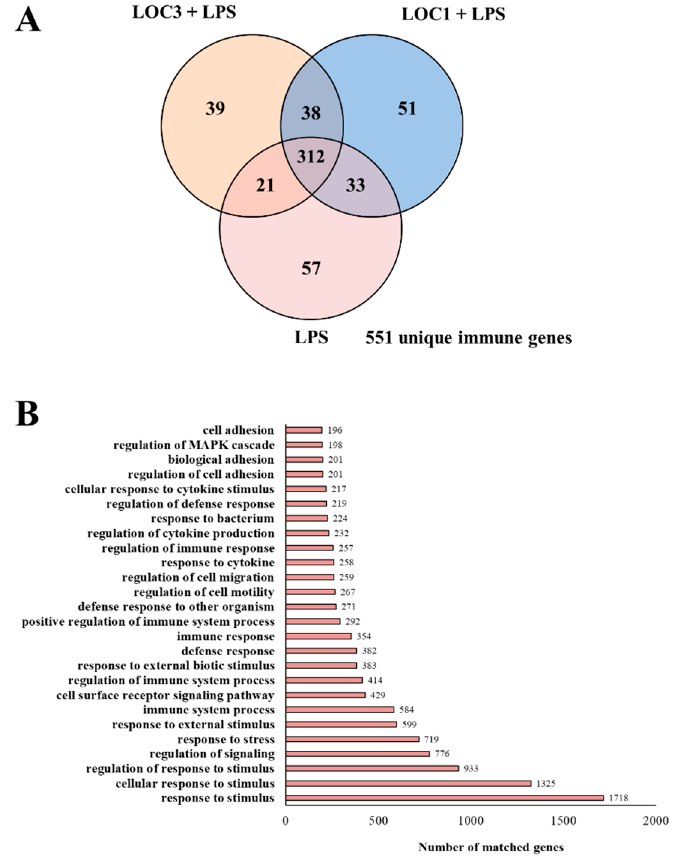
Figure 2. Effect of Lactiplantibacillus plantarum strains isolated from fresh tea leaves in murine RAW macrophages stimulated with the Toll-like receptor 4 (TLR4) agonist lipopolysaccharide (LPS). Macrophages were treated with L. plantarum LOC1 or LOC3 strains and then challenged with LPS. The expression of genes was determined by microarray analysis 3 h after LPS stimulation. Non-lactobacilli-treated macrophages stimulated with LPS were used as control. Venn diagrams showing the number of differentially regulated immune ( A ) genes for each experimental group. Number of matched genes categorized according to the Gene Ontology (GO) database ( B ).